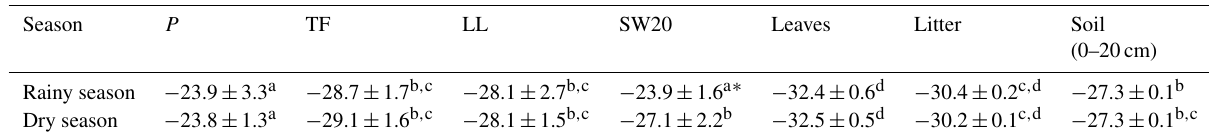
P indicates rainfall, TF indicates throughfall, LL indicates litter leachate, SW20 indicates soil water at a depth of 20cm. Different subscript letters indicate significant differences between the treatments according to least significant difference (LSD) test ( P <0.05). ∗ indicates the significant seasonal difference according to independent sample t test ( p <0.1).